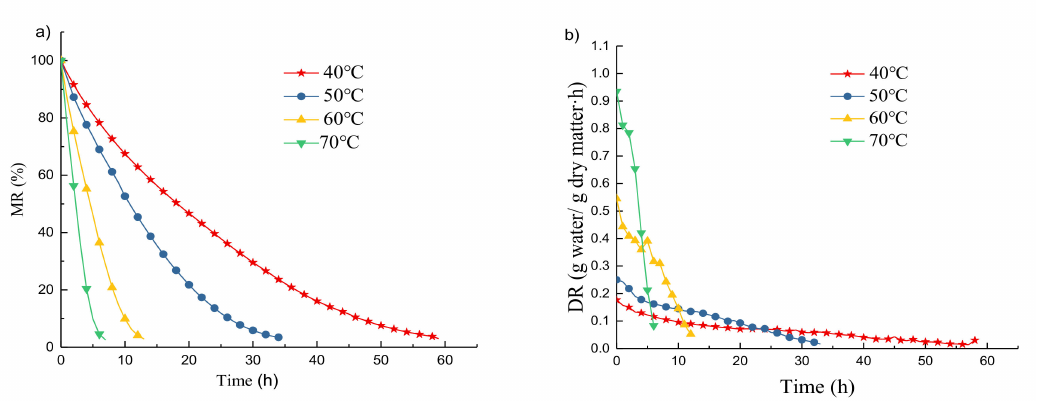
Figure 5. Variations of the moisture ratio ( a ) and drying rate ( b ) with drying time at a di ff erent temperature of drying air.